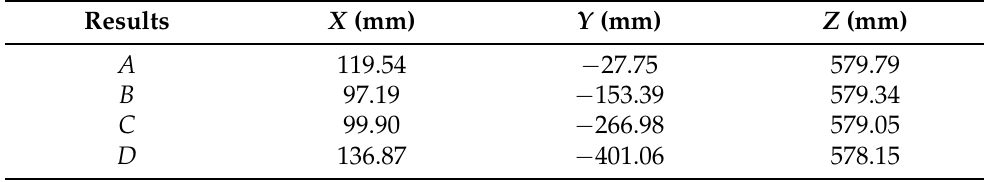
Table 10. Calculation results of space points of second experiment.